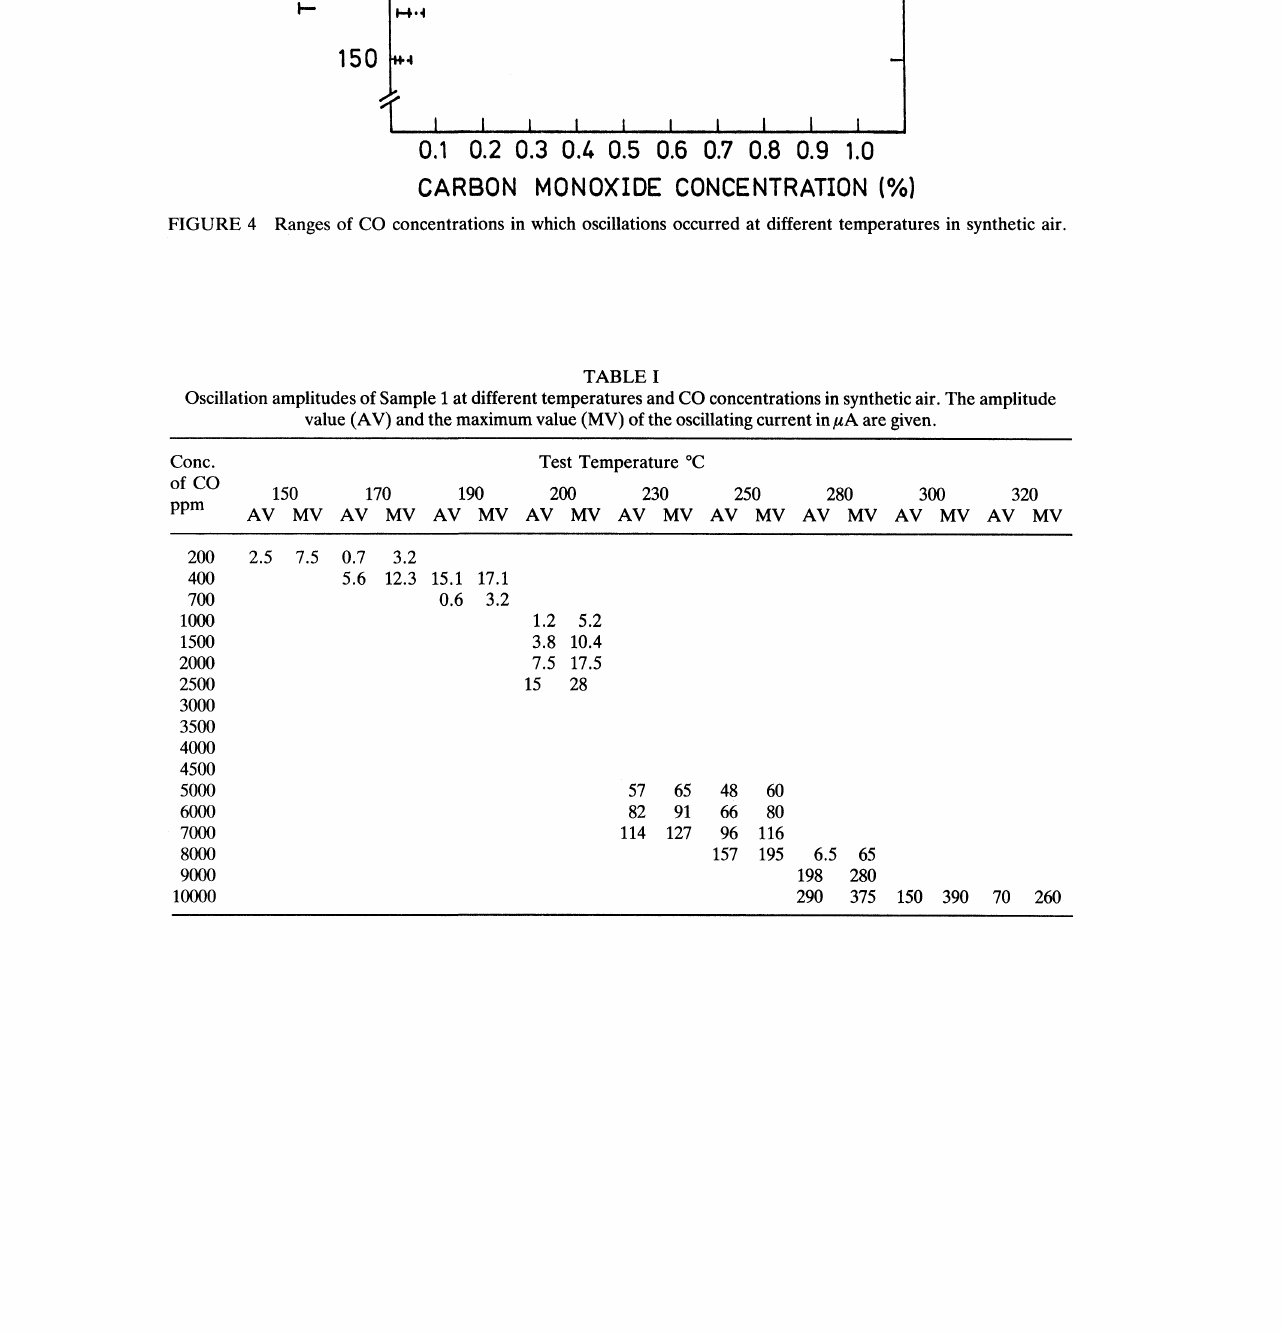
FIGURE 4 Ranges of CO concentrations in which oscillations occurred at different temperatures in synthetic air.